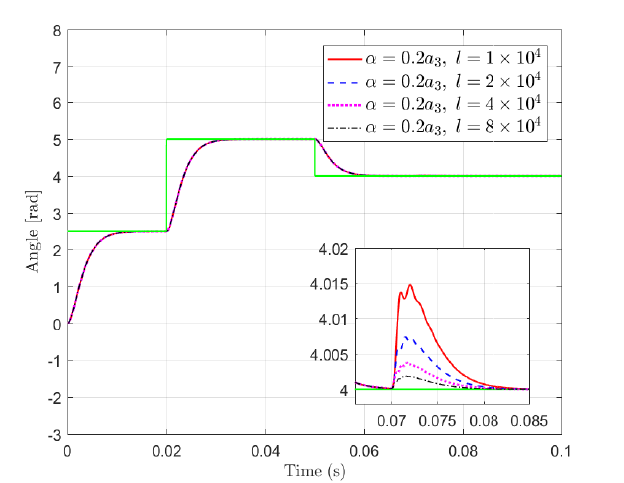
Figure 8. Performance comparison of ROPIO compensated ROMBC by increasing l with α = 0.2 a 3 .